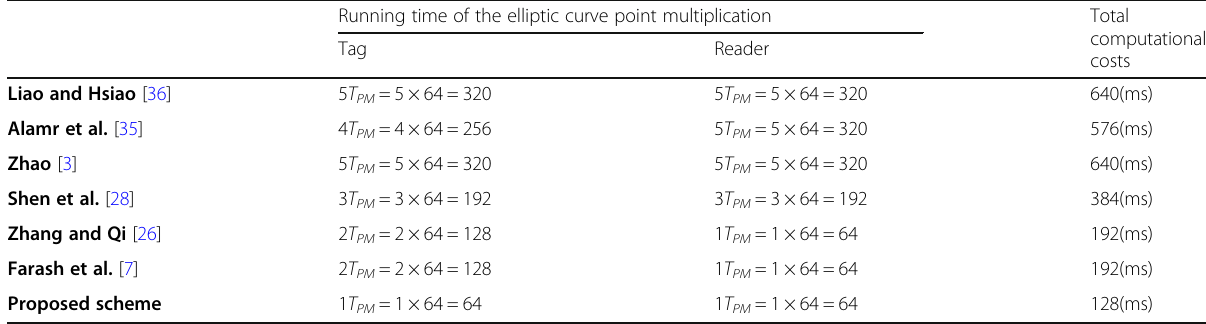
Table 6 The running time of the elliptic curve point multiplication among related protocols in authentication phase Running time of the elliptic curve point